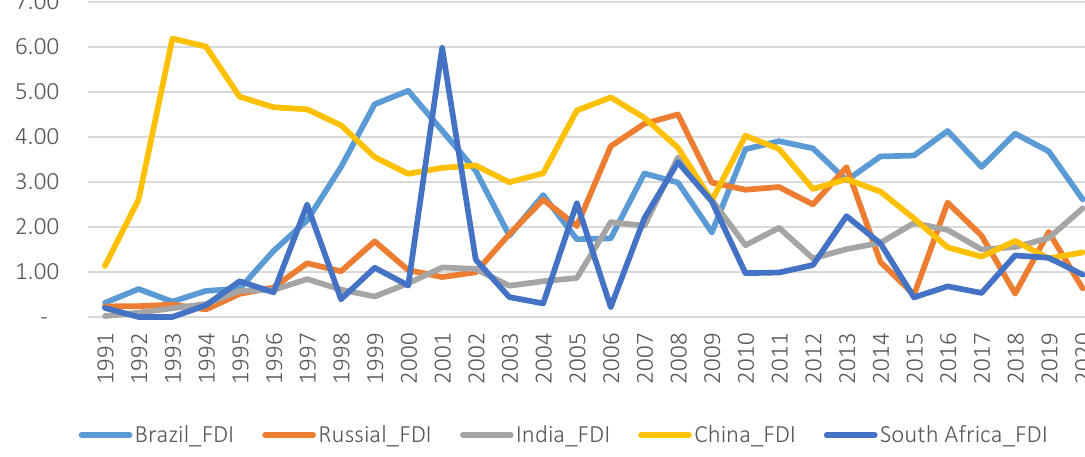
Figure 2. Net FDI inflow (% of GDP) trends in